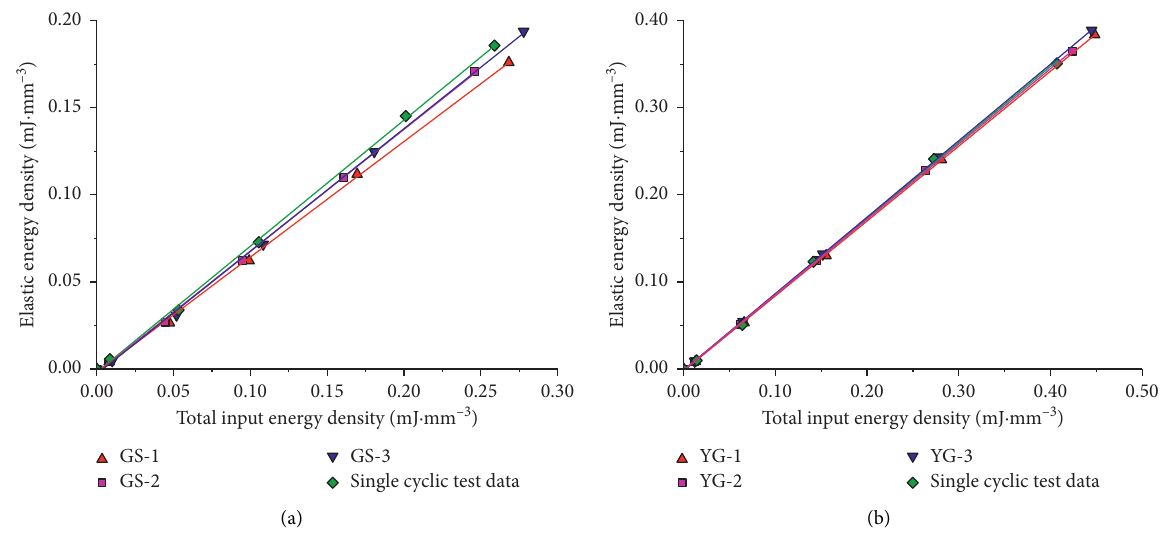
Figure 10: Relationship between the elastic and total input energy density of rock specimens in approach 2. (a) Green sandstone; (b) Yueyang granite. Table 4: Fitted functions between the elastic energy density and total input energy density.